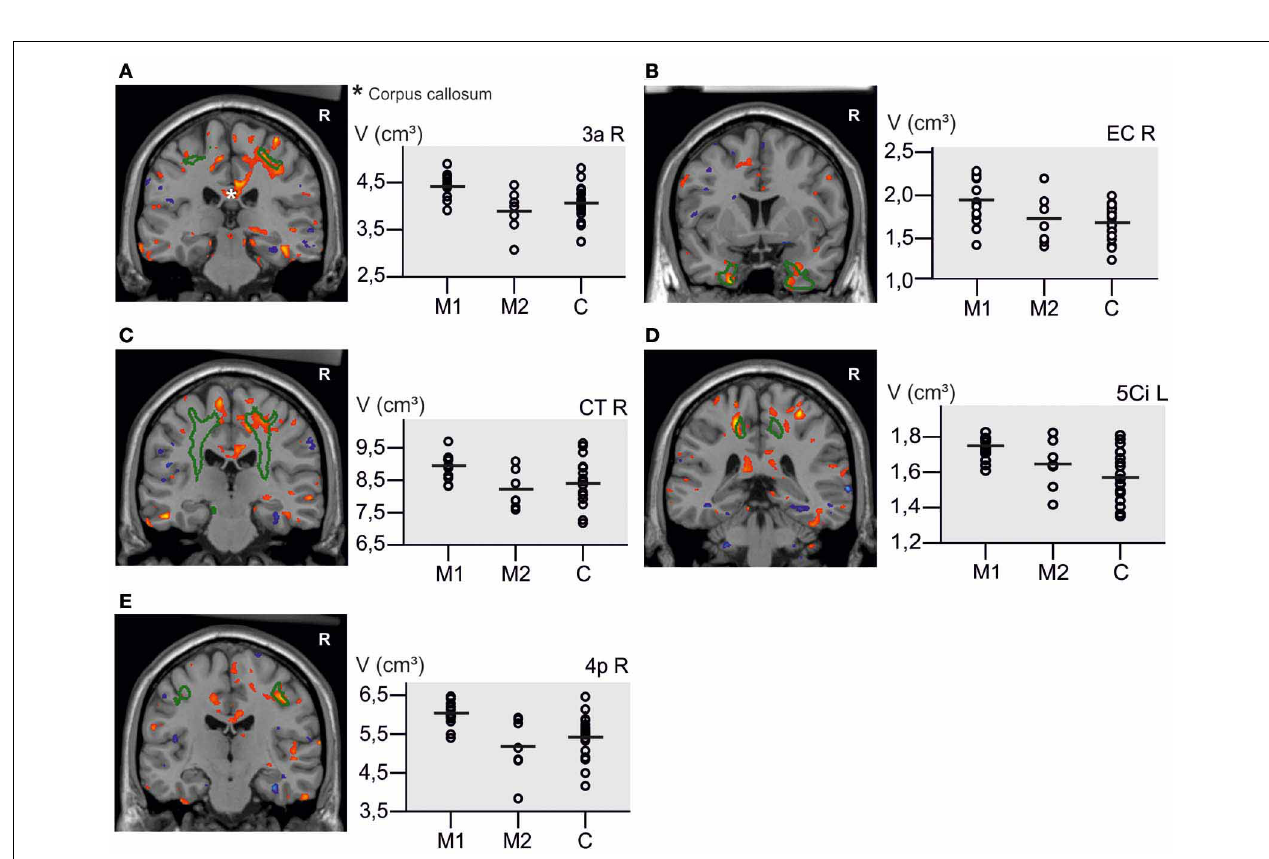
FIGURE 5 | Results from voxel-based and ROI-Analysis are overlaid. Volume increase (red) and volume decrease (blue) in M1 musicians compared to controls from the voxel-based analysis are used for visualization of the ROI results in five coronal slices (height threshold t = 2 . 03, threshold corresponds with p < 0 . 05, uncorrected for multiple comparisons). As green curves the contours of the regions used in the